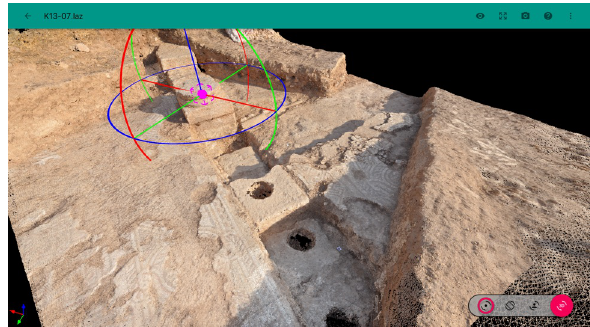
Figure 2 . Screenshot representing the PointoVIEWER interface.